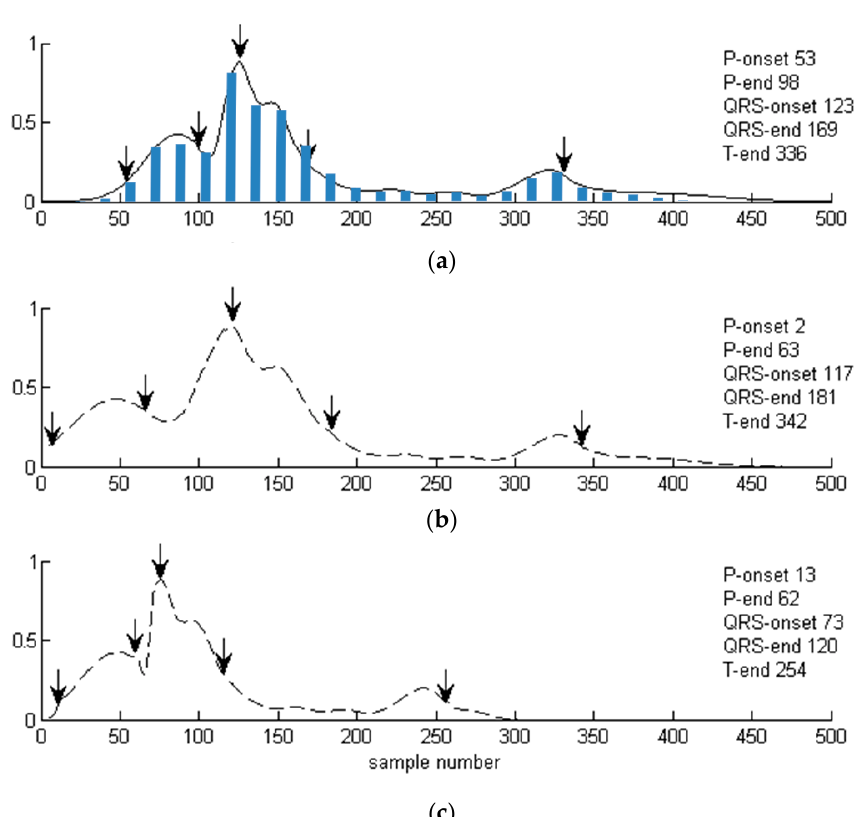
Figure 3. Projection of generalized medical relevance function (gMRF) to local positions of the heartbeat sections: ( a ) gMRF (with the bar graph it stems from), ( b ) aMRF (adapted medical relevance function) calculated for CSE-Mo001 record, ( c ) aMRF calculated for CSE-Mo003 record.